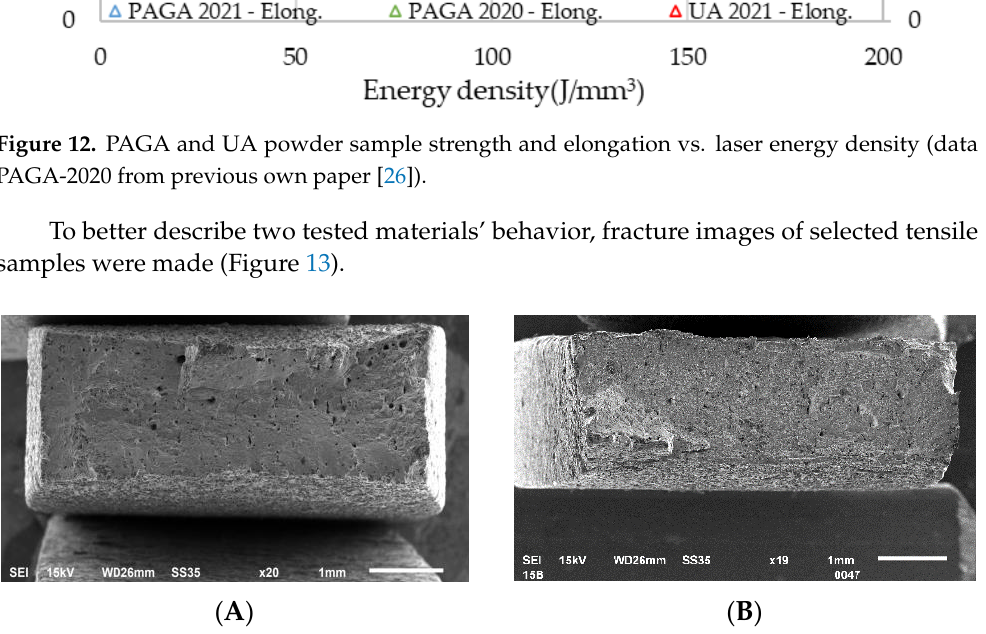
Figure 13. Fracture images of samples’ subjected to tensile testing: ( A )—PAGA; ( B )—UA. Both of the tested samples indicate a mixed character of cracking—mostly plastic, but with local features of brittle-like cracking. Samples made of UA powder indicate more areas of brittle cracking, when at the same time, in the samples made of PAGA powder, there are more voids visible. Such porosity (Figure 13A) could be related to lower energy density used for manufacturing, which caused local lack of fusion between some powder